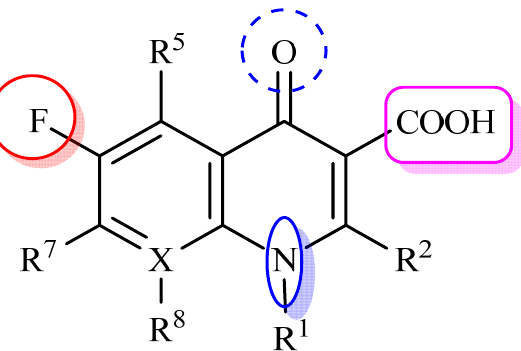
Figure 1. General structure of fluoroquinolones, using the accepted numbering scheme for positions on the molecule. The radicals R 1 , R 2 , R 5 , R 7 and R 8 indicate possible positions for structural modification; X usually corresponds to a C or N atom. Adapted with permission from [8].